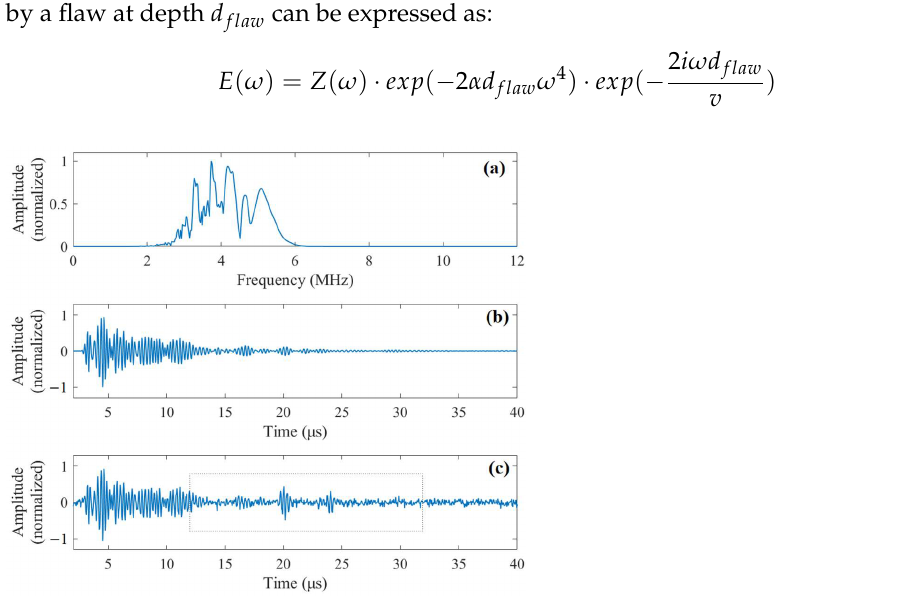
Figure 5. ( a ) Frequency spectrum of simulated grain noise. ( b ) The time-domain waveform of the simulated grain noise. ( c ) The simulated noisy